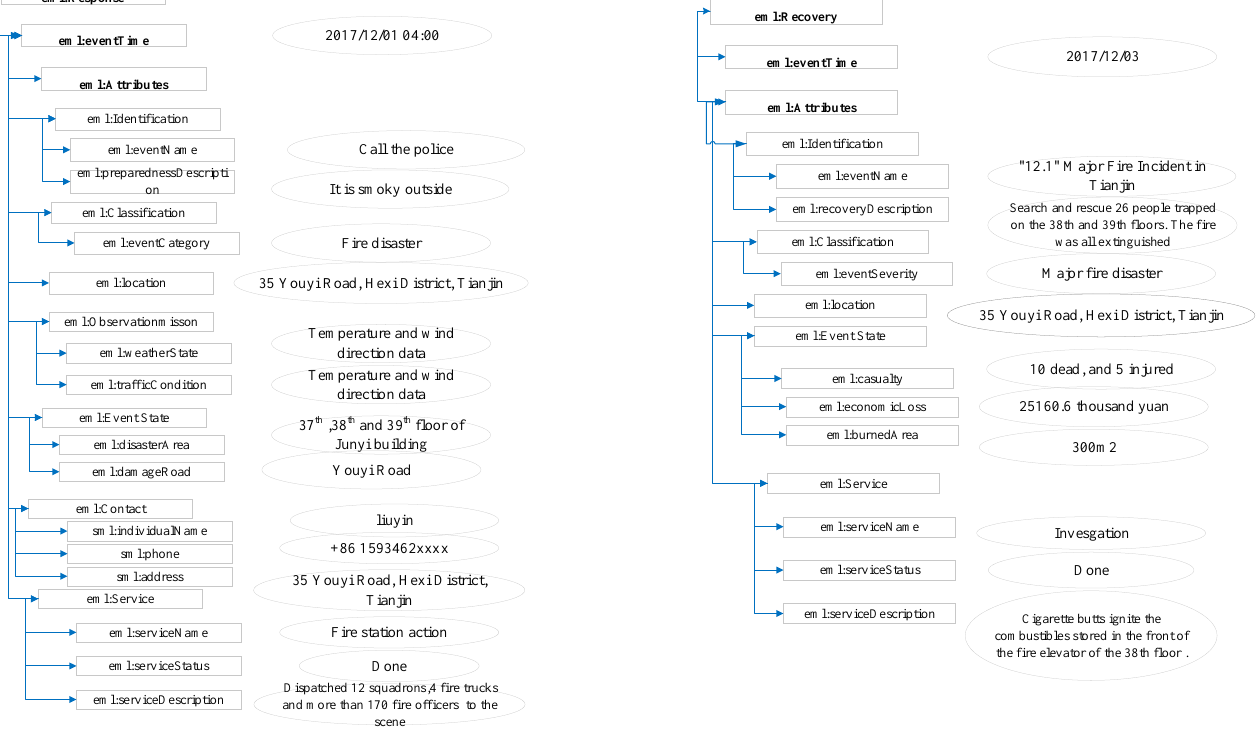
Figure 7. Response and recovery phase modelling